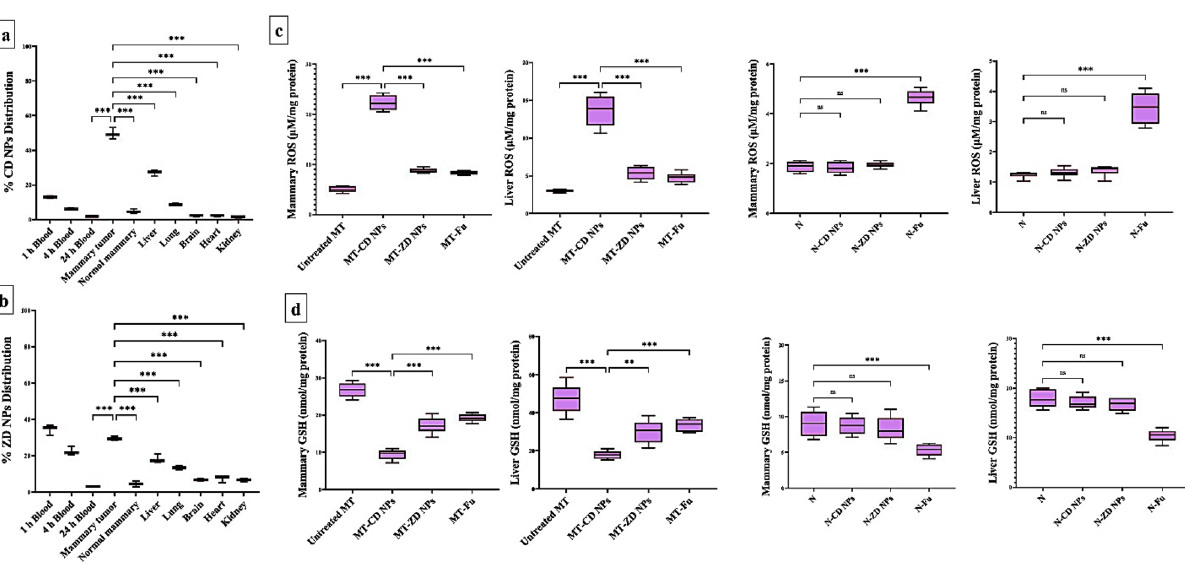
Figure 4. Nanocomplexes’ selective biodistribution in tumor tissues and selective ROS elevation with GSH depletion impacts. Selective biodistribution of ( a ) CD NPs and ( b ) ZD NPs in blood and tissues. All values are demonstrated as mean ± SEM. Mammary tumor was compared to other tissues, considering significantly different at p < 0.05*, < 0.01**, and < 0.001***. ( c ) ROS level (μM/mg protein) and ( d ) GSH content (nmol/ mg protein) in mammary tumor and liver of the untreated mammary tumor-bearing mouse group (MT), CD NPs-treated MT group (MT-CD NPs), MT-ZD NPs group, and MT-Fu group compared to normal mammary and liver tissues of healthy control (N) untreated group, CD NPs-treated N group (N-CD NPs), N-ZD NPs, and N-Fu. All values are demonstrated as mean ± SEM. MT-CD NPs group was compared to other groups, considering significantly different at p < 0.05*, < 0.01**, and <